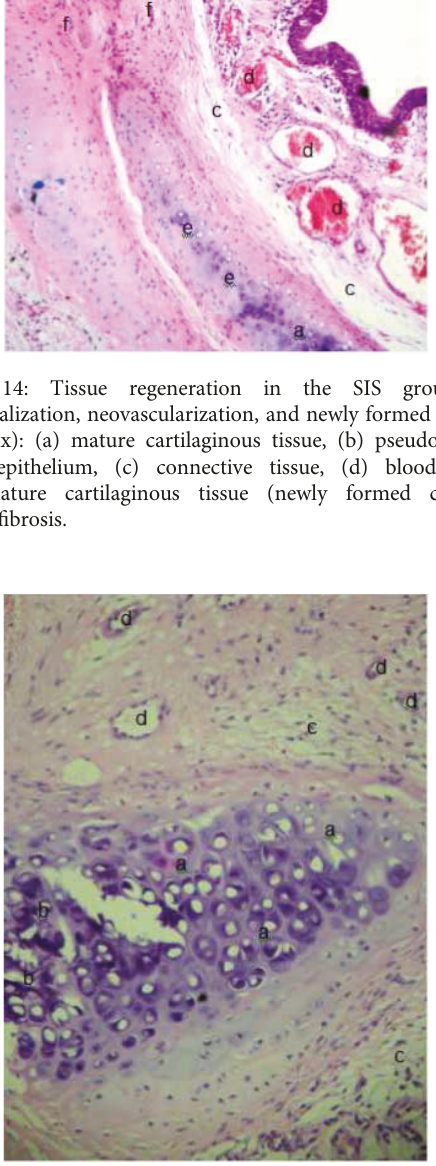
Figure 15: SIS group with immature cartilaginous tissue at the site of the tracheal defect, H&E (400x): (a) immature cartilaginous tissue (newly formed cartilage), (b) mature cartilaginous tissue, (c) connective tissue, and (d) blood vessels.